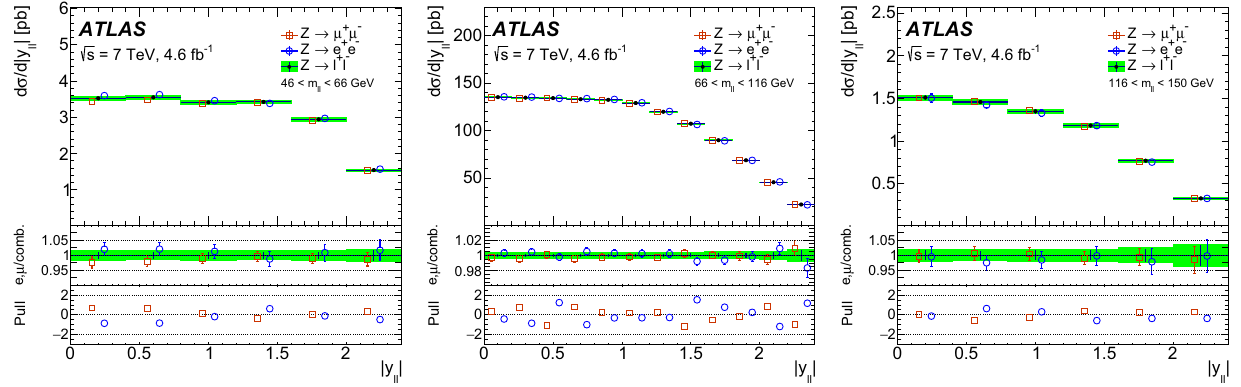
Fig. 17 Differential d σ/ d | η (cid:3) | cross-section measurements for W + ( left ) and W − ( right ), for the electron channel ( open circles ), the muon channel ( open squares ) and their combination with uncorrelated uncer- tainties ( crosses ) and the total uncertainty, apart from the luminosity